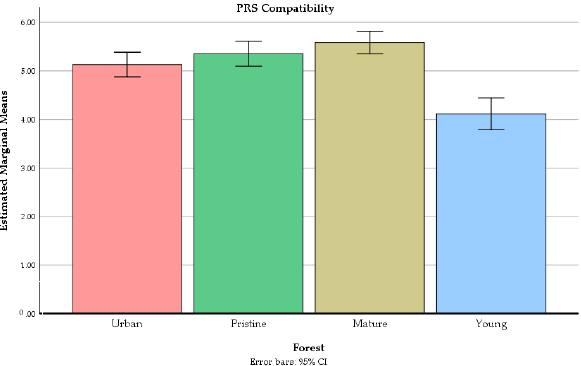
Figure 7. The mean values of PRS compatibility in four different forests at the end of the experiment. Error bars represent 95% confidence intervals.